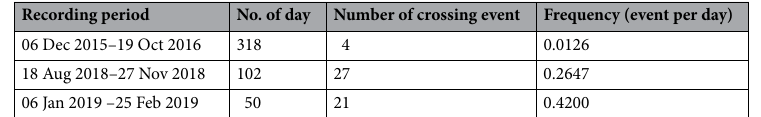
Table 1. Usage frequency of artificial canopy bridge by the Hainan gibbon group during the three study periods in 2015–2019.